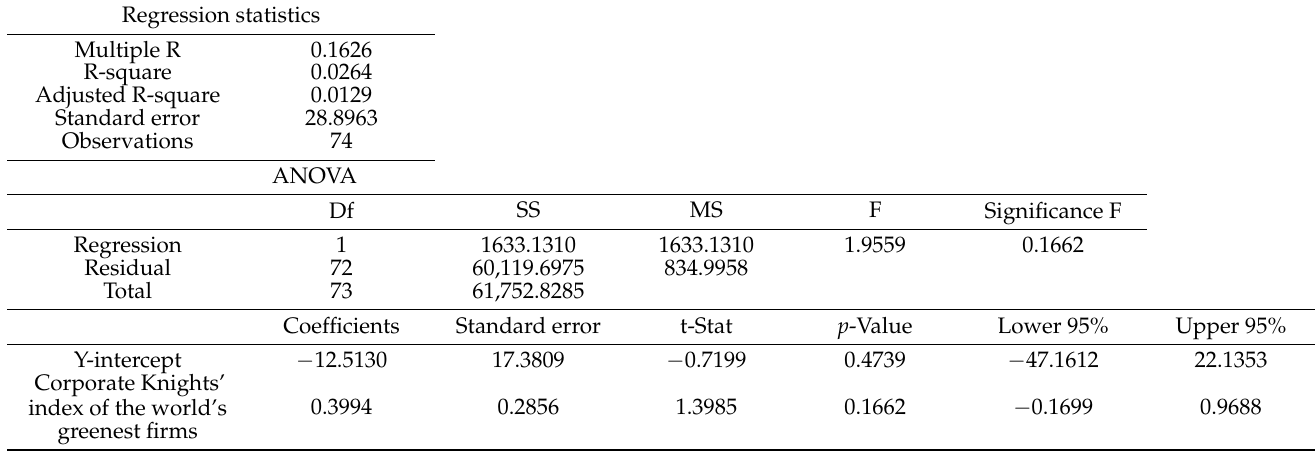
Table 3. Regression analysis of the dependence of the risk of revenue reduction on the level of corporate social responsibility in 2020–2021.